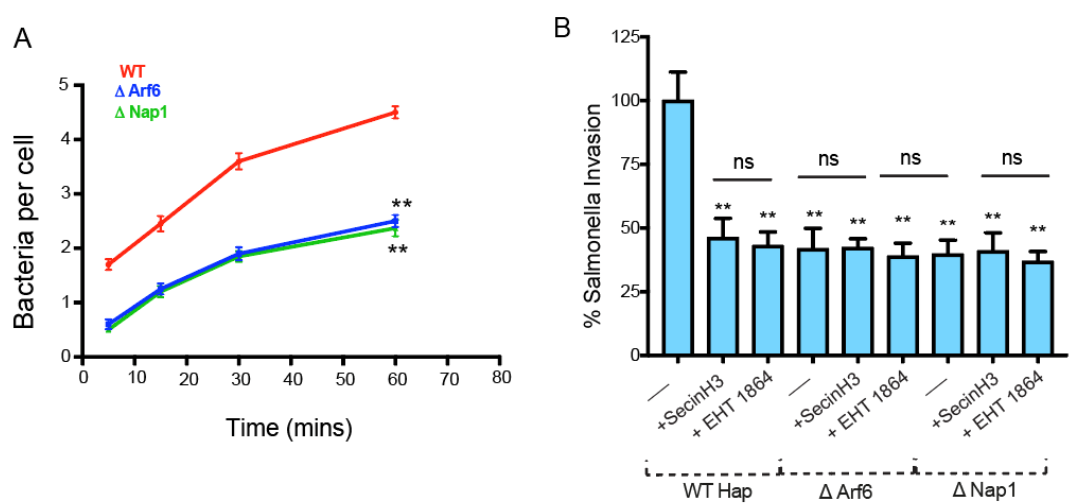
Figure 4. ( A ) Time course of Salmonella invasion in WT Haps, ΔArf6 (blue) , or ΔNap1 (green) Hap cells with Salmonella bacteria carrying pM975 that express GFP inside pathogen-containing